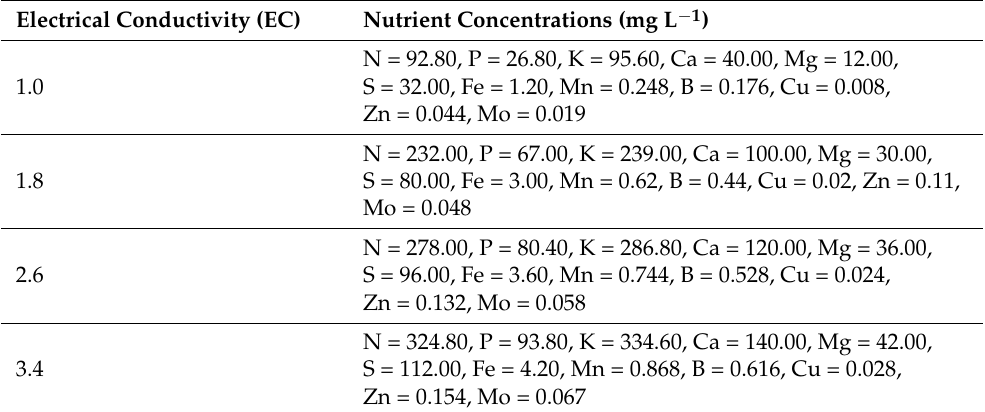
Table 1. Mineral composition of nutrient